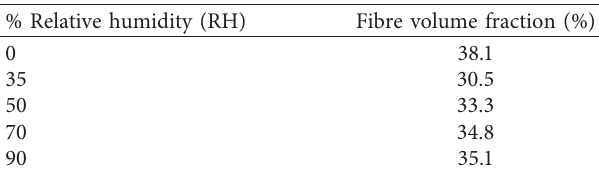
Figure 1: Composite plates manufacturing process: (a) surface image of the flax fabric, (b) schematic of the vacuum infusion process, (c) setup of the vacuum infusion process: ongoing resin infusion, and (d) composite plate. Table 1: Average fiber volume fraction of the specimens under different relative